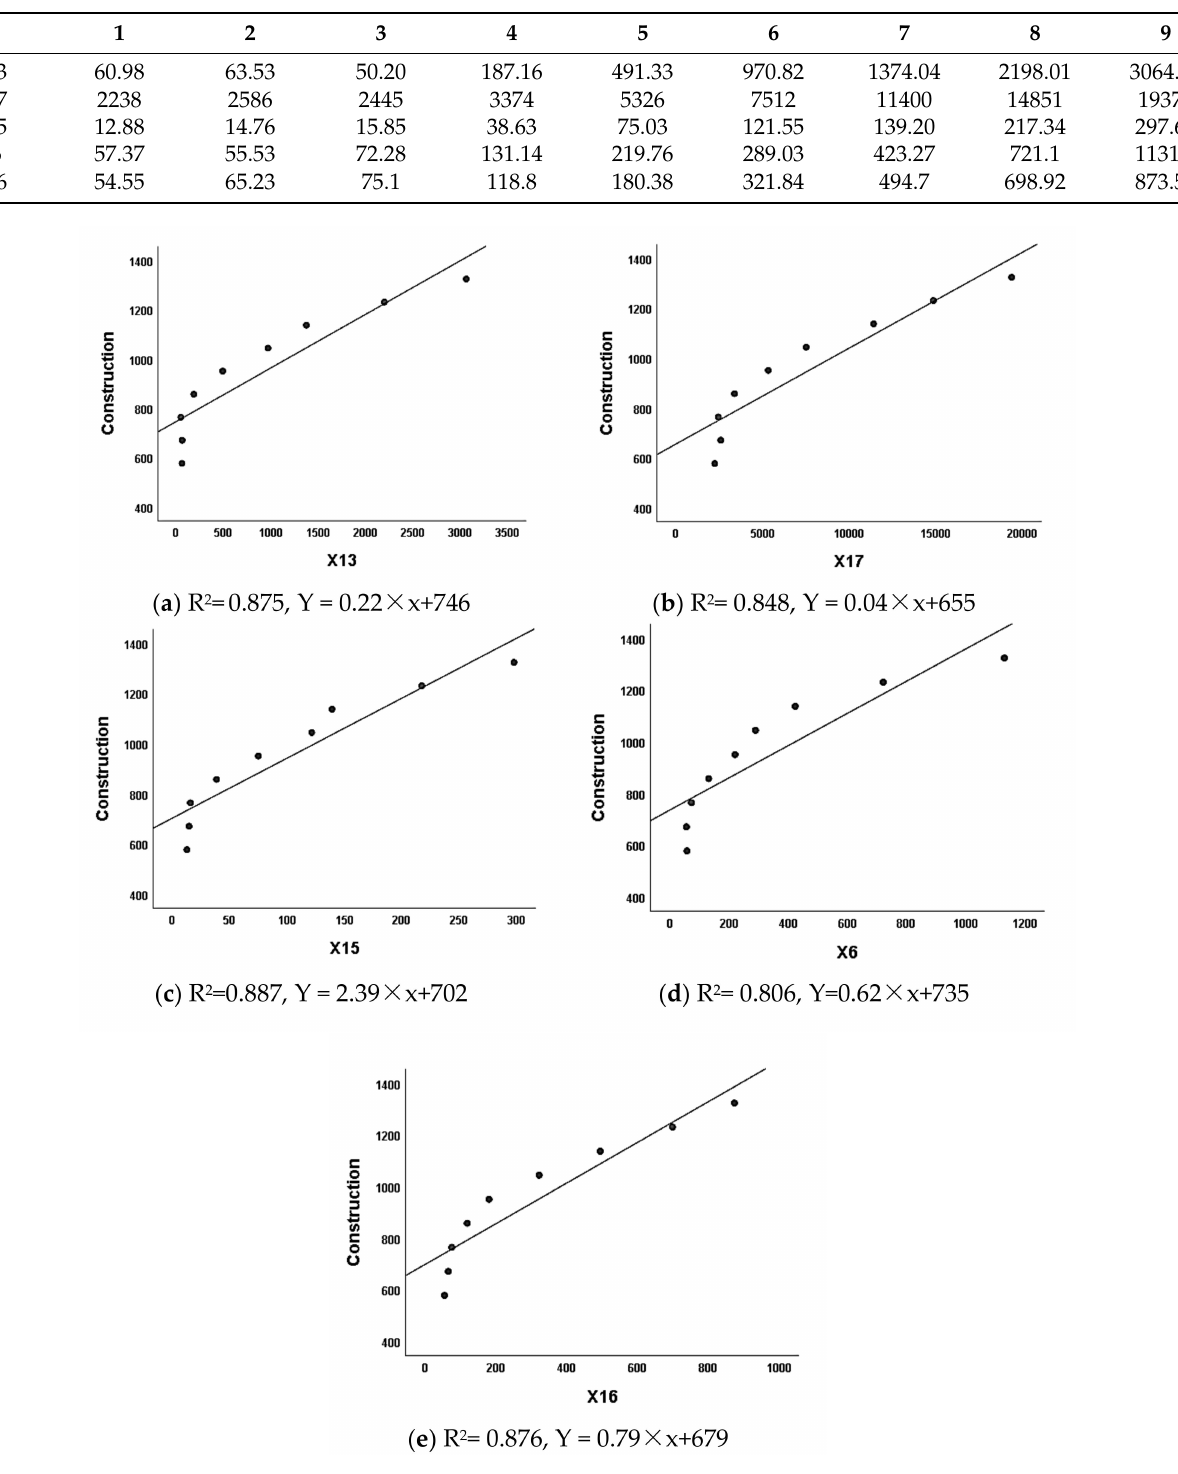
Figure 9. Regression analysis model